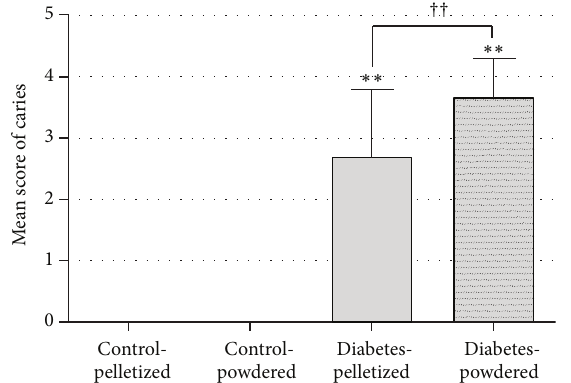
Figure 4: The mean scores for caries in the mandibular molars of each group. Significant difference from the control group ( ∗∗ 𝑃 < 0.01 ) and from the diabetes-pelletized diet group ( †† 𝑃 < 0.01